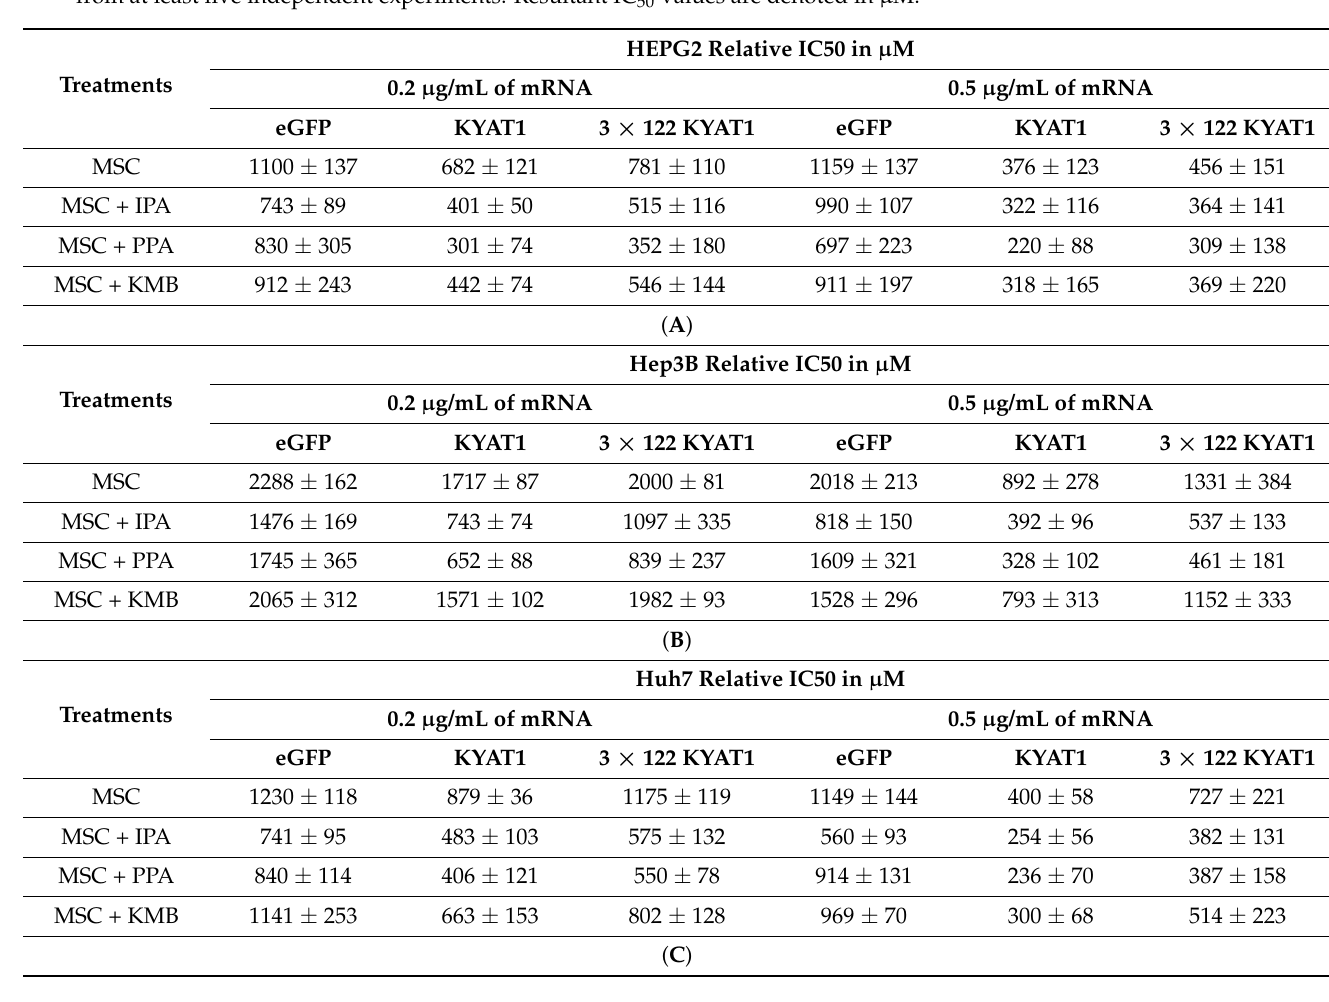
Table 3. ( A ) Relative IC 50 values for MSC alone or in combination with modifiers at 72 h in HEPG2 cells transfected with 0.2 µ g/mL and 0.5 µ g/mL of eGFPmRNA, KYAT1mRNA, and 3 × 122KYAT1mRNA. Results are represented as mean ± SD from triplicate measurements from at least five independent experiments. Resultant IC 50 values are denoted in µ M. ( B ) Relative IC 50 values for MSC alone or in combination with modifiers at 72 h in Hep3B cells transfected with 0.2 µ g/mL and 0.5 µ g/mL of eGFPmRNA, KYAT1mRNA, and 3 × 122KYAT1mRNA. Results are represented as mean ± SD from triplicate measurements from at least five independent experiments. Resultant IC 50 values are denoted in µ M. ( C ) Relative IC 50 values for MSC alone or in combination with modifiers at 72 h in Huh7 cells transfected with 0.2 µ g/mL and 0.5 µ g/mL of eGFPmRNA, KYAT1mRNA, and 3 × 122KYAT1mRNA. Results are represented as mean ± SD from triplicate measurements from at least five independent experiments. Resultant IC 50 values are denoted in µ